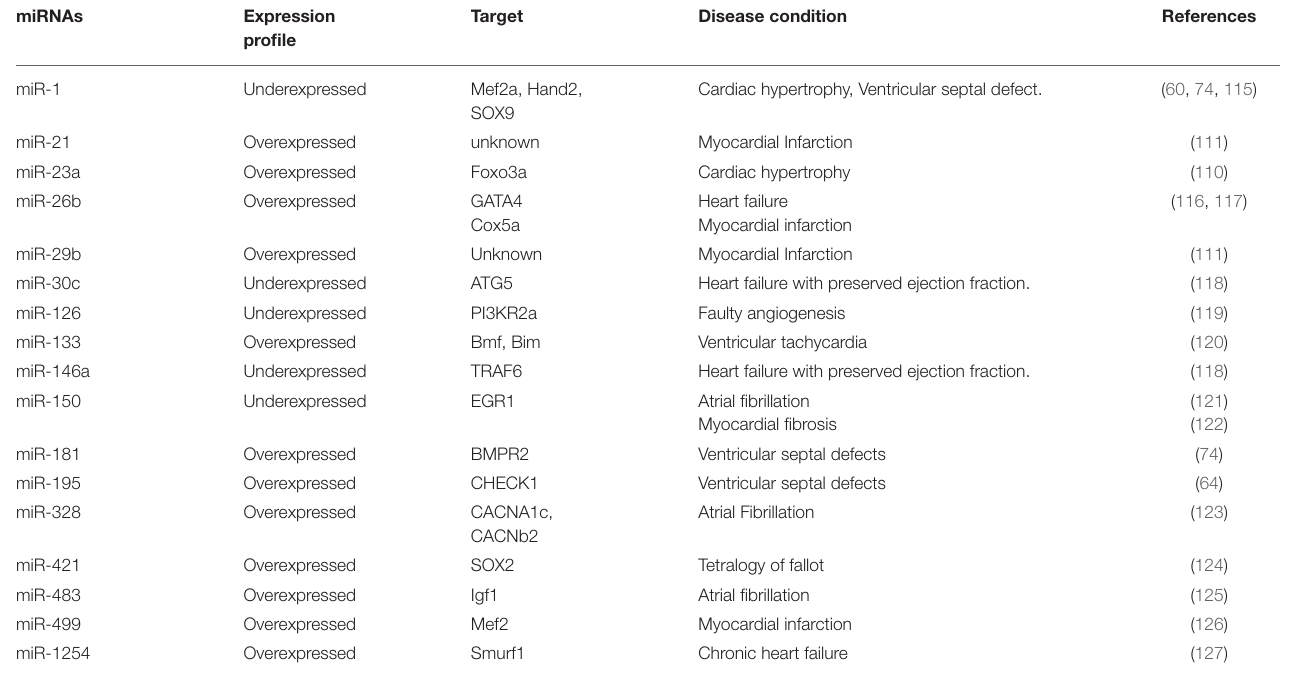
TABLE 3 | Cardiovascular disease associated with miRNAs.